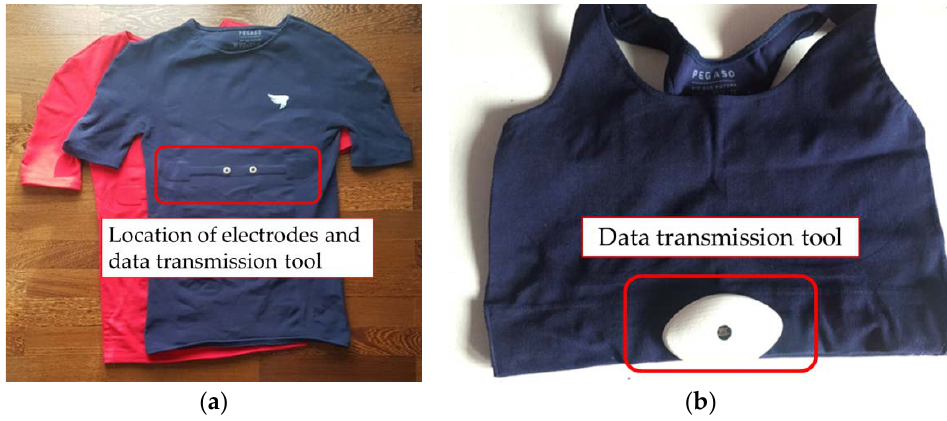
Figure 2. ( a ) T-shirts used for the tests, equipped with sensors; ( b ) female version of the wearable sensor.